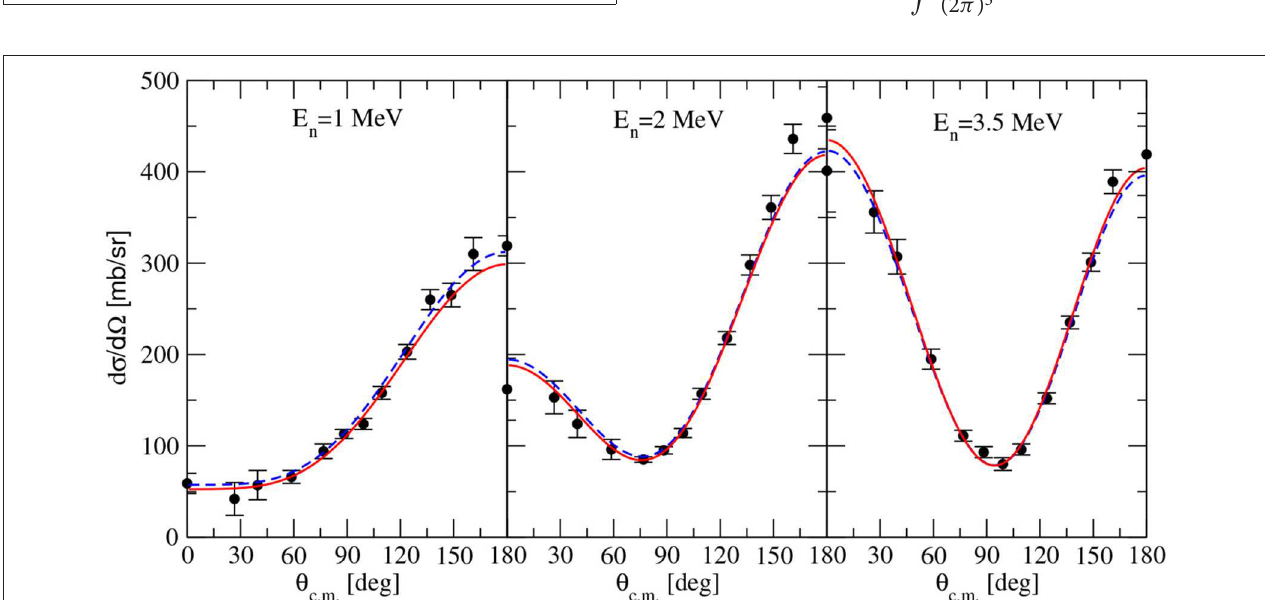
FIGURE 5 | n − 3 H differential cross sections calculated with the N3LO-I (dashed blue lines) and the N3LO-I/N2LO (solid red lines) interaction models for three different incident neutron energies. The experimental data are from reference [92].